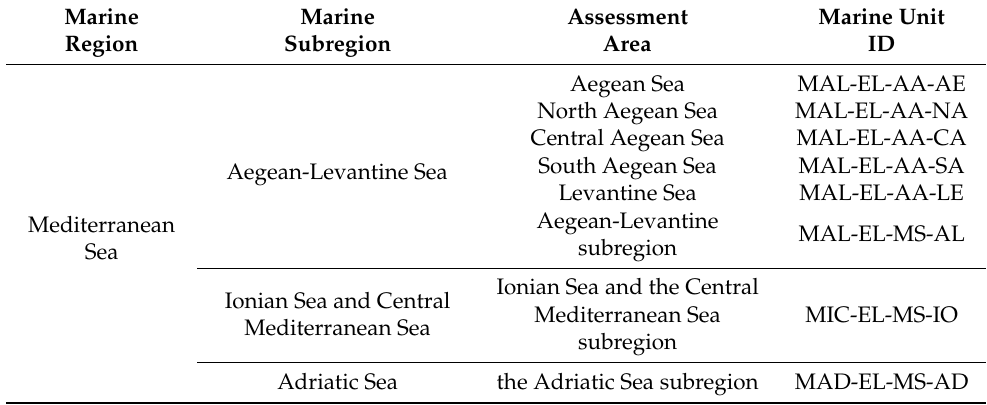
Figure 2. The geographical boundaries of the Greek assessment areas, as reported in 2012 [17]. Table 1. The identity of the Greek waters, as reported in 2012